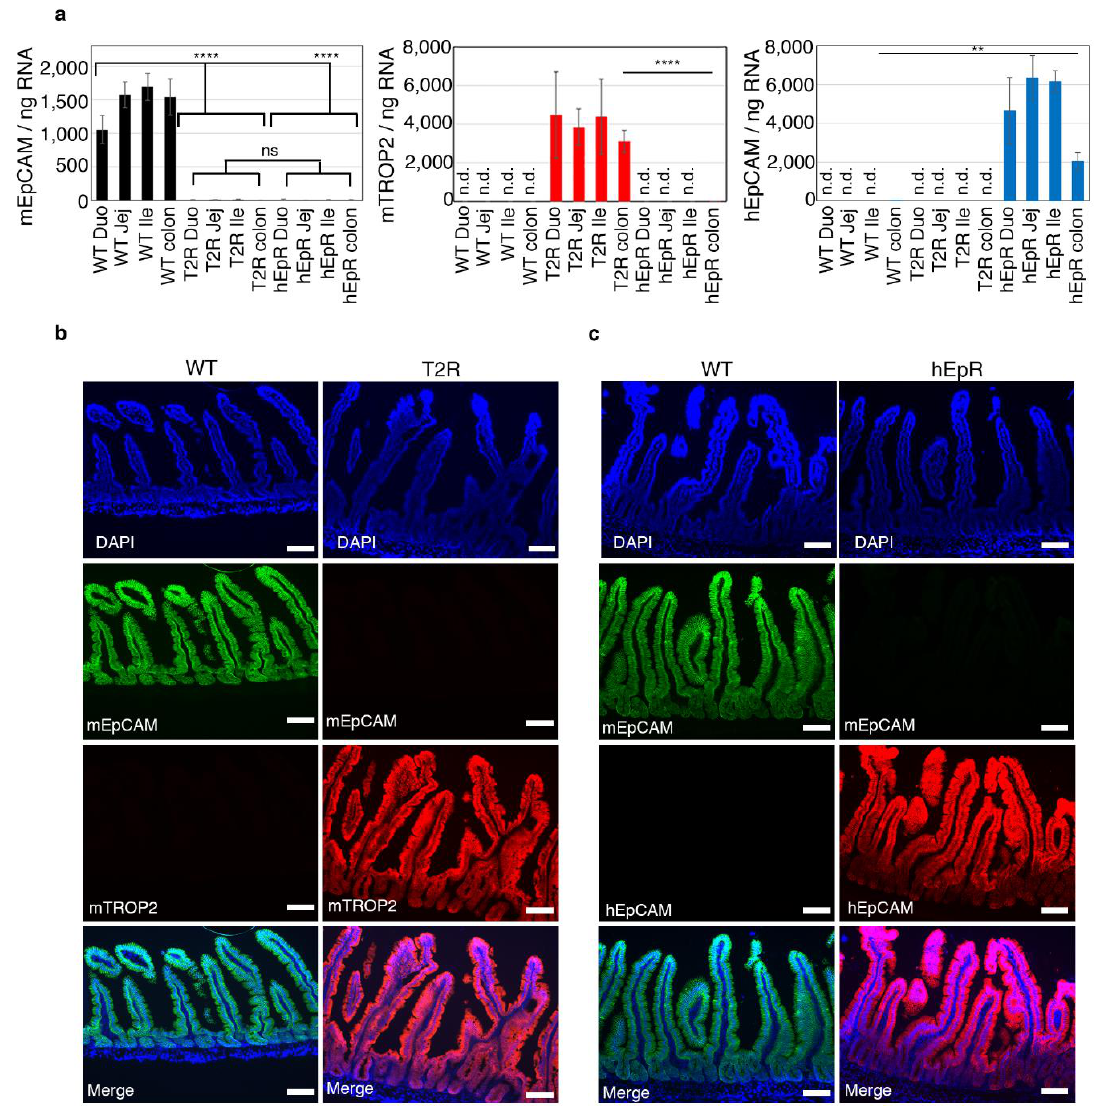
Figure 1. Expression of EpCAM and TROP2 in intestinal epithelial cells (IEC) of transgenic and control mice. ( a ) Absolute numbers of murine EpCAM, murine TROP2, and human EpCAM transcripts in 1 ng intestinal total RNA were determined using quantitative RT-PCR. Data represent means ± SD in samples from 4 mice in each group ( n = 4). ** p < 0.01, **** p < 0.0001 using a one-way ANOVA with Tukey’s multiple comparison test. n.d. means not detected. ( b ) Immunofluorescence microscopy verifying expression of murine EpCAM (green) and murine TROP2 (red) in the small intestines of wild type (WT) and murine TROP2 rescue (T2R) mice. Nuclei were stained with 4 (cid:48) ,6-diamidino-2-phenylindole (DAPI) (blue). Scale bars, 100 µ m. ( c ) Immunofluorescence microscopy verifying expression of murine EpCAM (green) and human EpCAM (red) in the small intestines of WT and human EpCAM rescue (hEpR) mice. Nuclei were stained with DAPI (blue). Scale bars, 100 µ